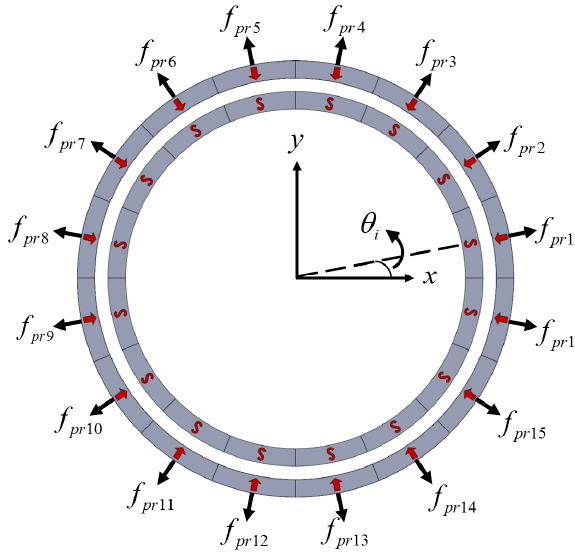
Figure 12. A top-view on PMB and the radial force for 16 sets of passive magnetic units.